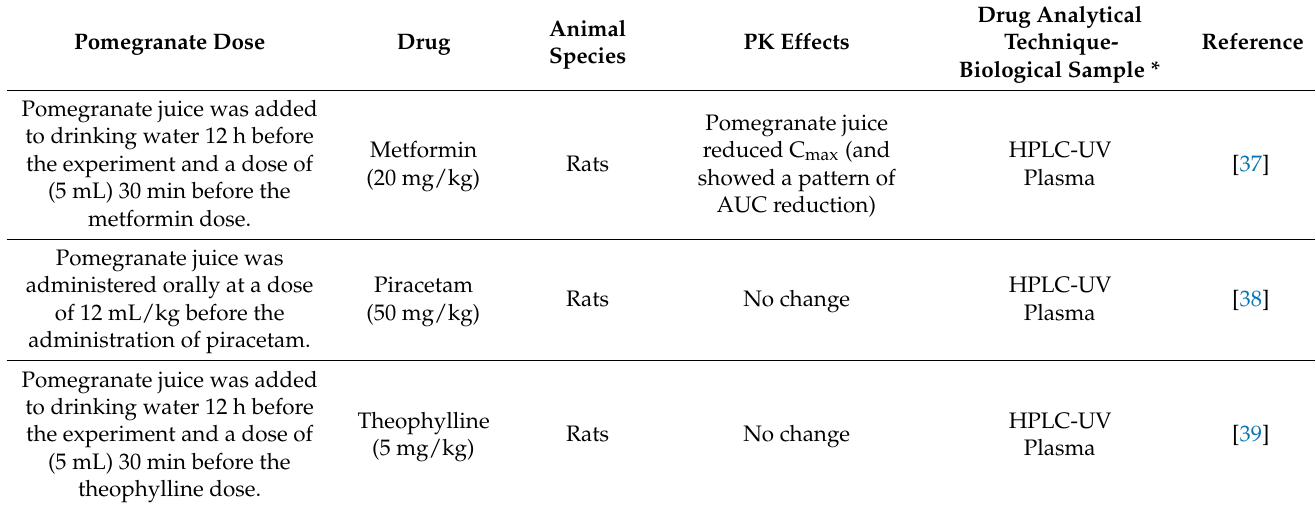
Table 2. Preclinical studies investigating the effect of oral administration of pomegranate juice on